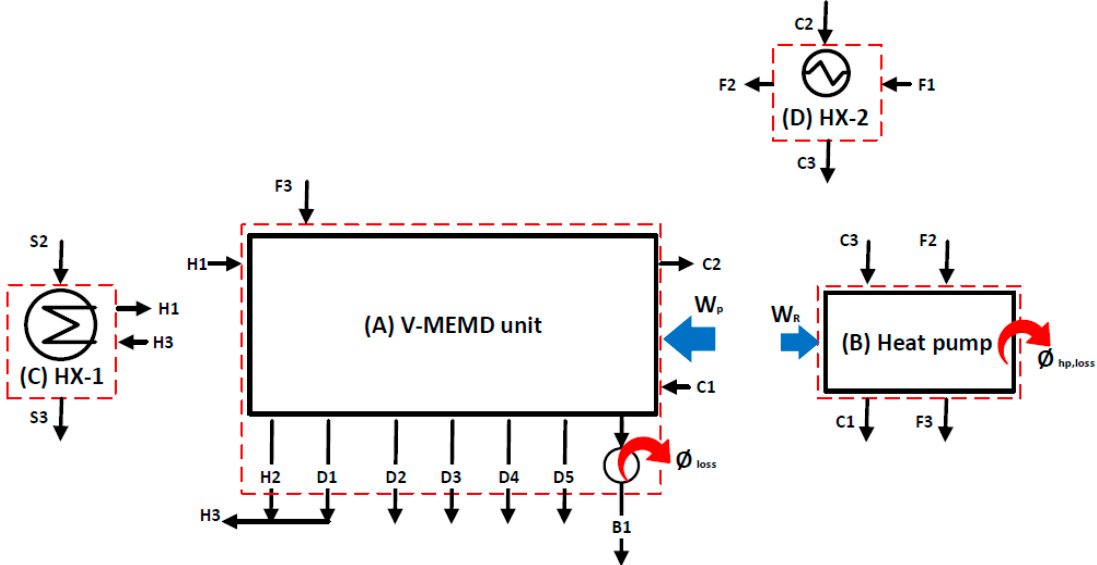
Figure 5. Specification of control volumes for major components: ( A ) V-MEMD unit, ( B ) heat pump system, ( C ) HX-1, and ( D ) HX-2.